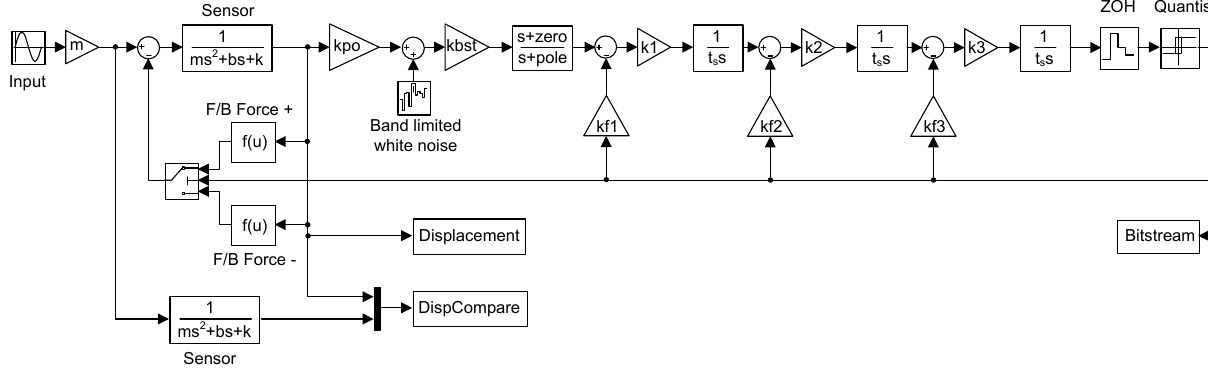
Figure 3. Simulink model of a 5th order EM ΣΔ M for a MEMS accelerometer.